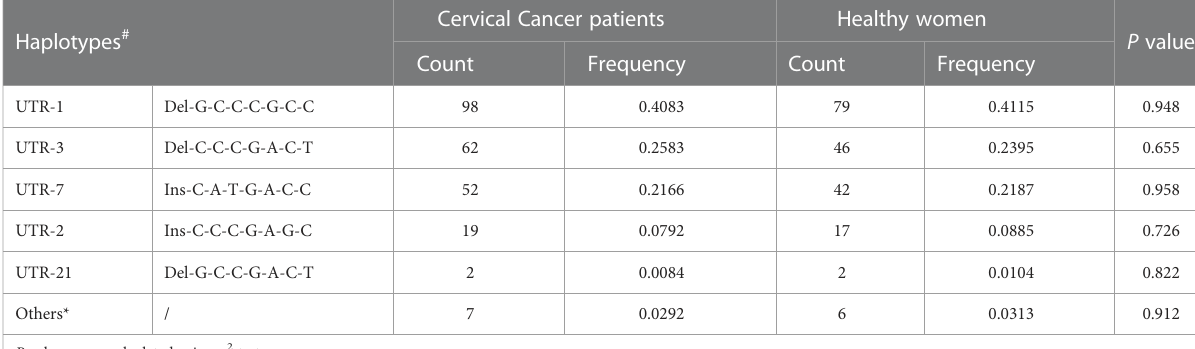
TABLE 3 HLA-G 3 ’ UTR haplotype frequencies among patients and controls.